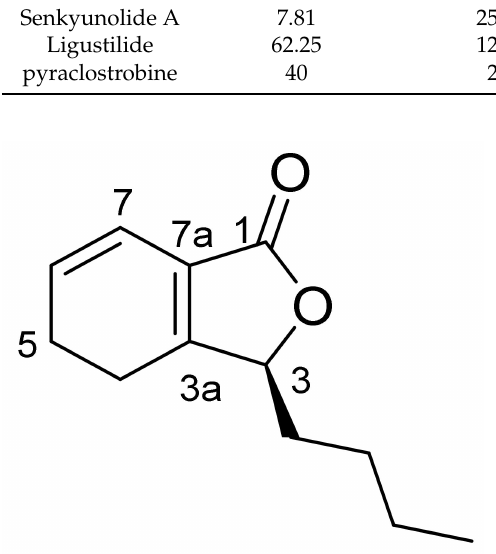
Figure 1. Structural formula of Senkyunolide